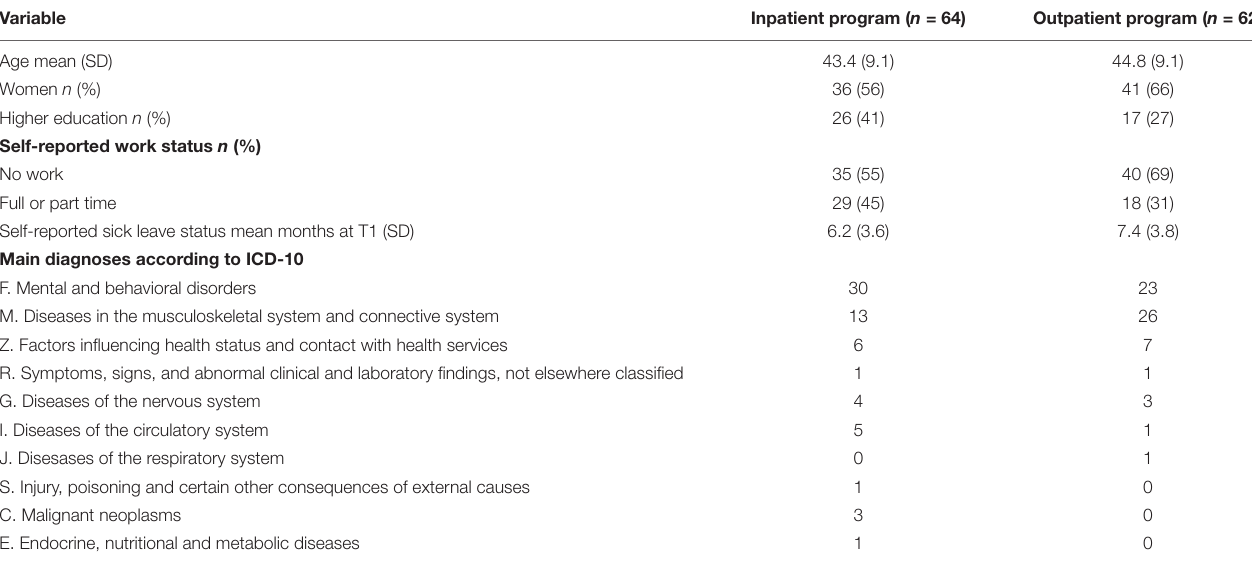
TABLE 1 | Baseline characteristics and referral diagnostics of